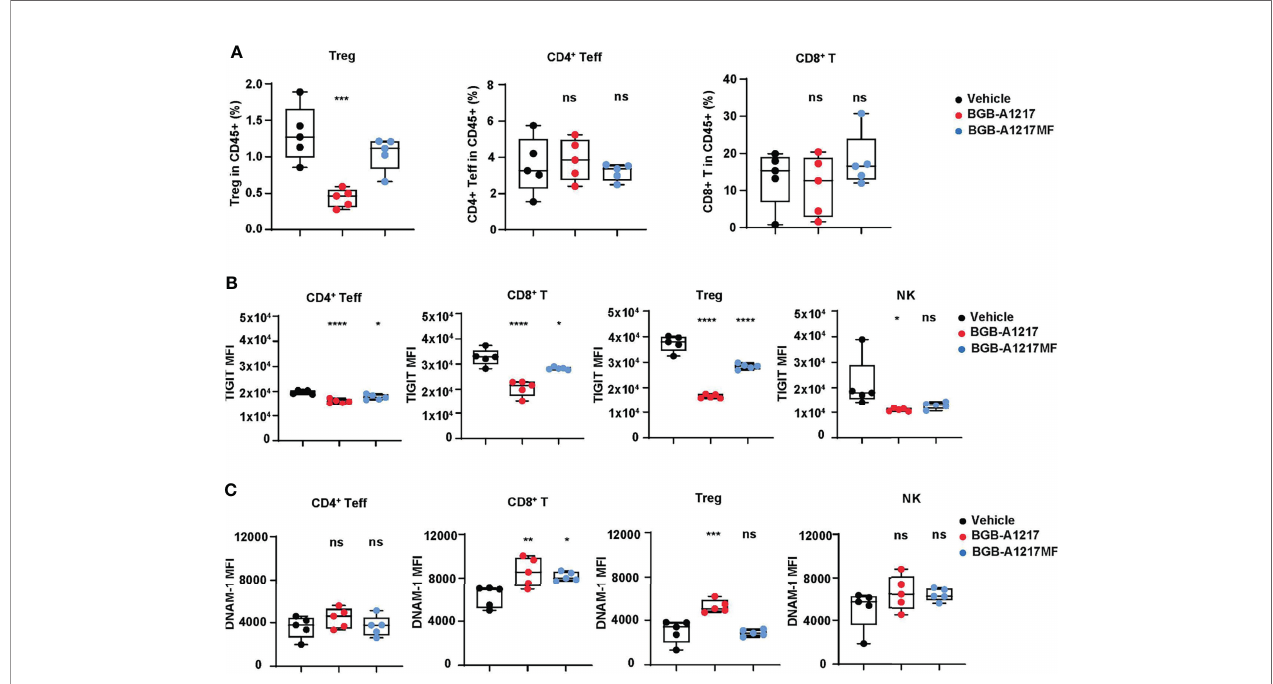
FIGURE 7 | BGB-A1217 reduces Tregs, down-regulates TIGIT and up-regulates DNAM-1 on T cells in an Fc effector function dependent manner in vivo . CT26.WT tumor-bearing human TIGIT knock-in mice were treated with BGB-A1217 or BGB-A1217MF at 3 mg/kg. Tumor in fi ltrating lymphocytes were analyzed by FACS 48h after treatment. (A) Intra-tumor Treg, CD4 + T eff , CD8 + T cell frequencies. (B) hTIGIT or (C) DNAM-1 MFI on T cell subsets and NK cells. Data shown as mean ± SEM, N = 5. Ordinary one-way ANOVA with Dunnett multiplicity adjustment was used. * p < 0.05, ** p < 0.01, *** p < 0.001, **** p < 0.0001. ns, no signi fi cant